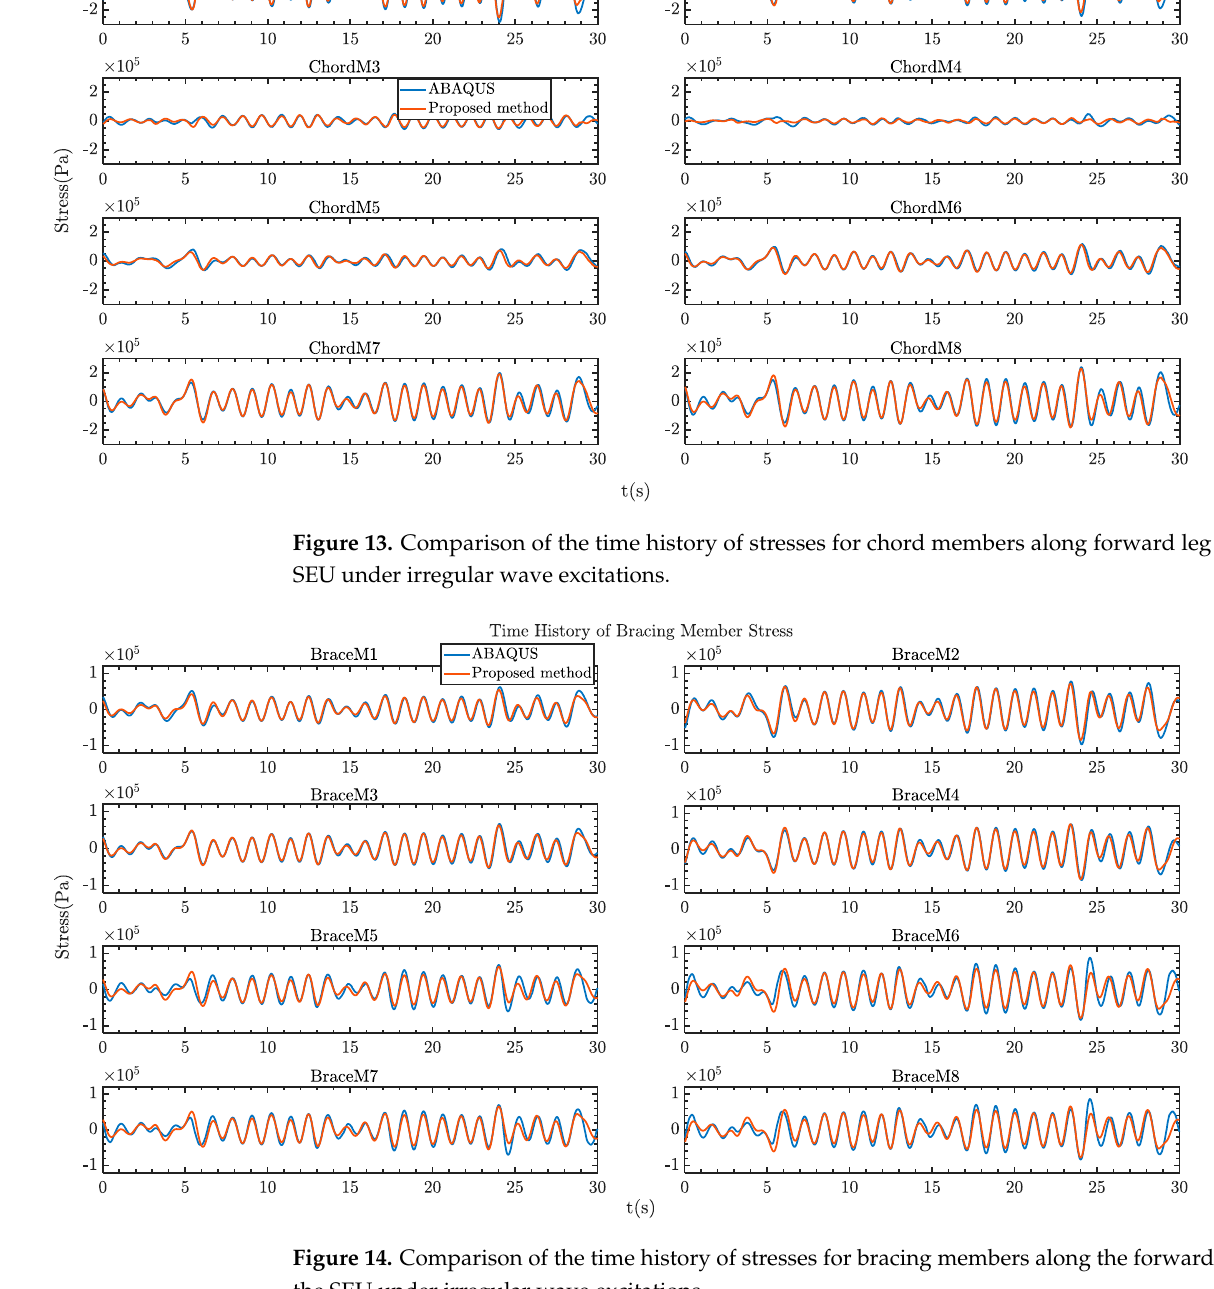
Figure 14. Comparison of the time history of stresses for bracing members along the forward leg of the SEU under irregular wave excitations.